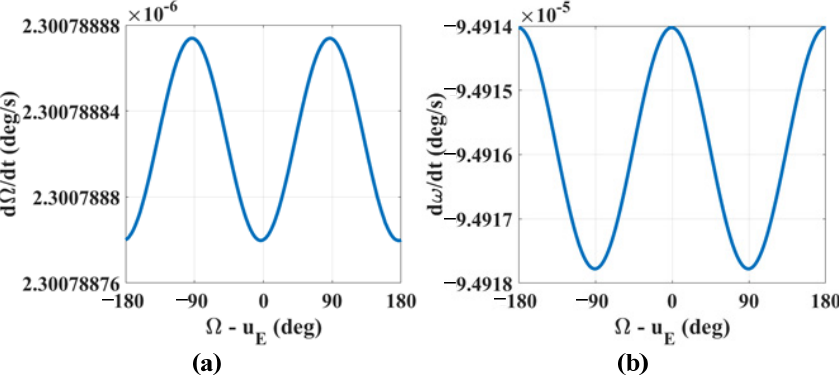
Figure 5. Rates of change of the longitude of the ascending node ( a ) and the argument of periapsis ( b ), for a = 1.2 R E , e = 0.001, i = 93 ° , and ω = 35 ° .